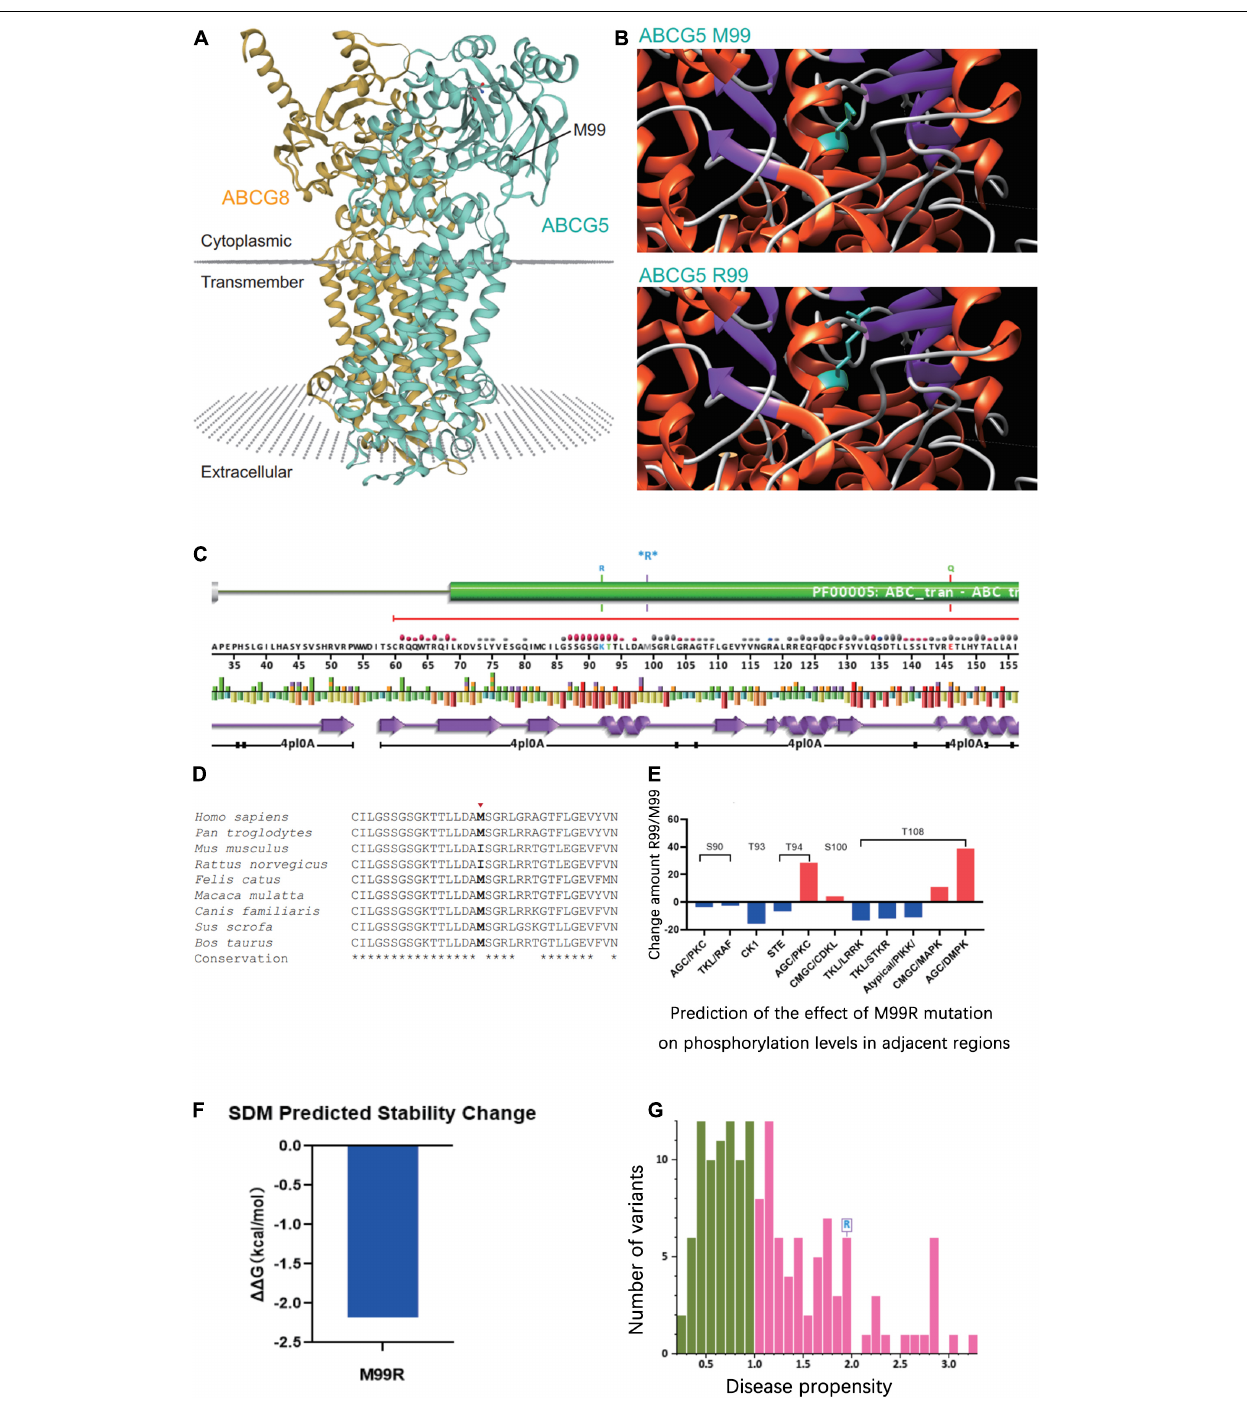
FIGURE 2 | Prediction of the effect of the ABCG5 (NM_022436) c.296 T > G (p.M99R) variant on the tertiary structure of ABCG5 . (A) Tertiary structure of the ABCG5 / ABCG8 heterodimer (https://swissmodel.expasy.org/repository/uniprot/Q9H222?template=5do7). Green indicates ABCG5 and orange indicates ABCG8 . The position marked by the arrow indicates ABCG5 p.M99R. (B) Prediction of changes in the tertiary structure of ABCG5 after p.M99R mutation (green) by Chimera (https://community.chocolatey.org/packages/chimera/1.15). (C) Protein structural information at the p.M99R site. Functional prediction of the ABCG5 M99R mutation (http://smart.embl-heidelberg.de/). (D) Conservation analysis of amino acid sequences near ABCG5 M99R. (E) GPS 5.0 predicts the effect of M99R on phosphorylation modifications of nearby amino acid sequences (http://gps.biocuckoo.cn/). (F) DUET predicts the stability effect of M99R on ABCG5 (http://structure.bioc.cam.ac.uk/duet). (G) Prediction of the pathogenicity of ABCG5 M99R by VarSite (https://www.ebi.ac.uk/thornton-srv/databases/VarSite). The pink areas are all pathogenic mutations, and the higher the score of the number of variants, the stronger the pathogenicity.